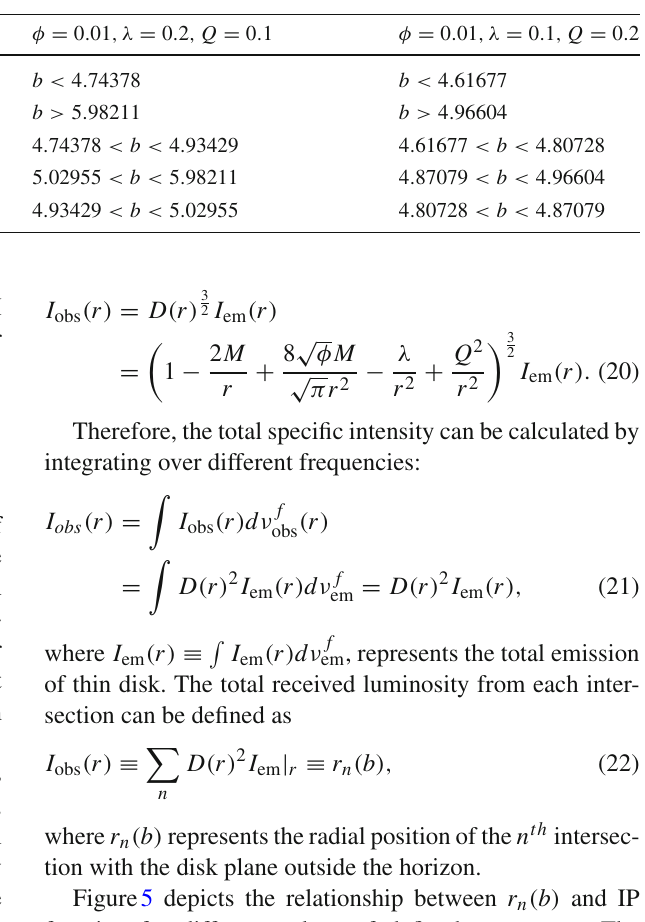
Fig. 3 The light rays for different specific values of model parameters in polar coordinates ( r ,ϕ) with M = 1. The purple and red curves classified the b > b ph and b < b ph regions, respectively. The dashed green line denotes the radius of photon sphere and solid black disk represents the BH face orientation Table 4 The numerical values of direct emission, lensing emission and of these emissions for other choices of model parameters. However, the photon ring emission are related to IP under specific values of model value M = 1 is fixed for all parameters. In the similar manner, we can analyze the numerical values